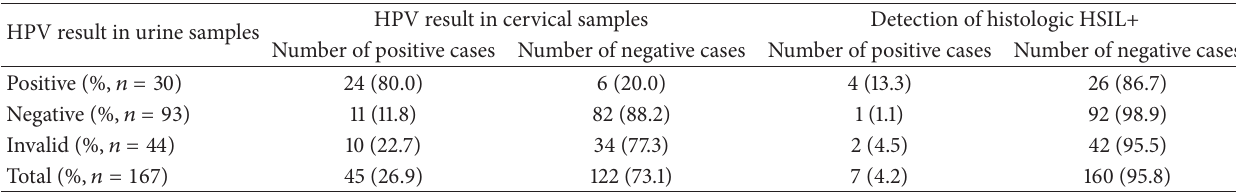
Table 1: Comparison of Cobas HPV results in urine samples with cervical samples and histology.